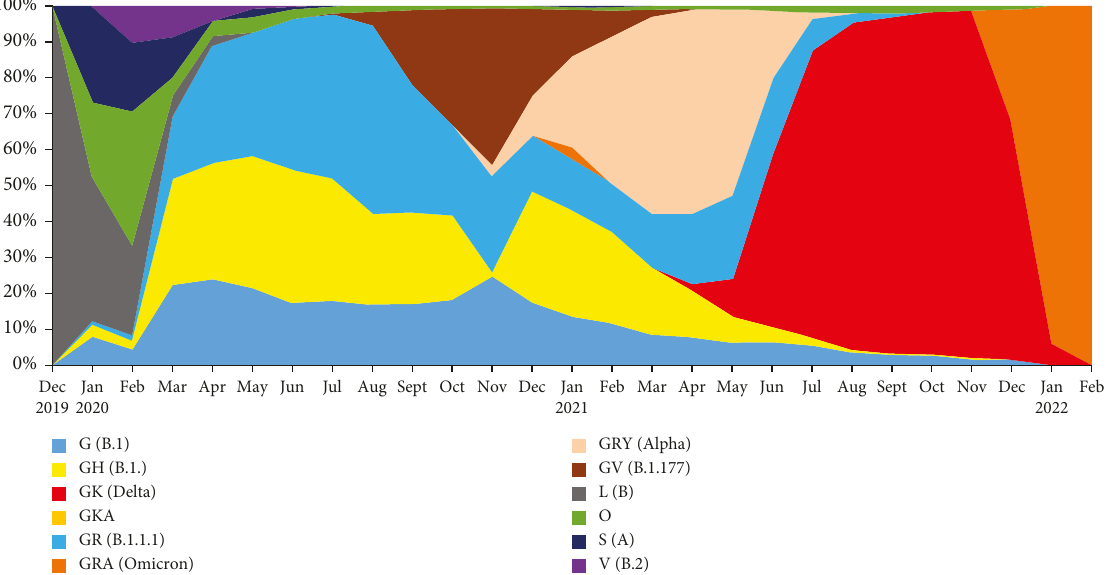
Figure 3: shows the increasing prevalence/distribution of SARS-CoV-2G clade in 2020 and the domination of the G clade VOCs in